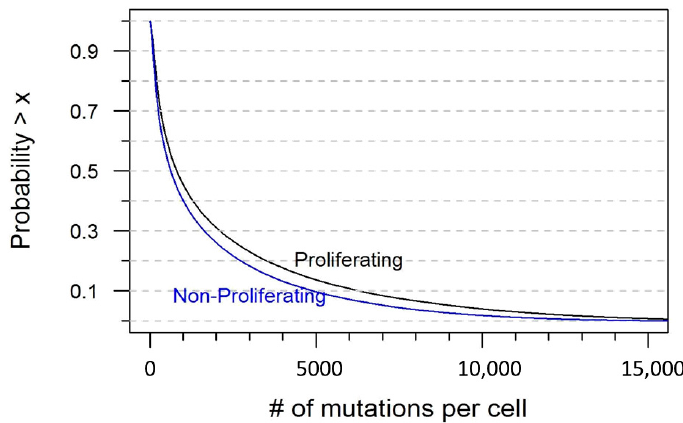
Figure 2. Reversed cumulative distribution of mutations per cell at the age of 70.